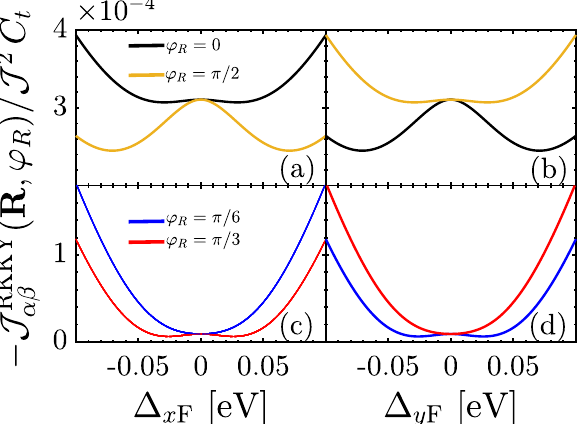
( R , ϕ R )/ J 2 C t as a function of ferroelectric J RKKY Figure 15. The behavior of the RKKY interaction αβ − distortion potential ( a ), ( c ) (cid:31) x F and ( b ), ( d ) (cid:31) y F for four different complementary angels ϕ R between two 25 magnetic moments at R =